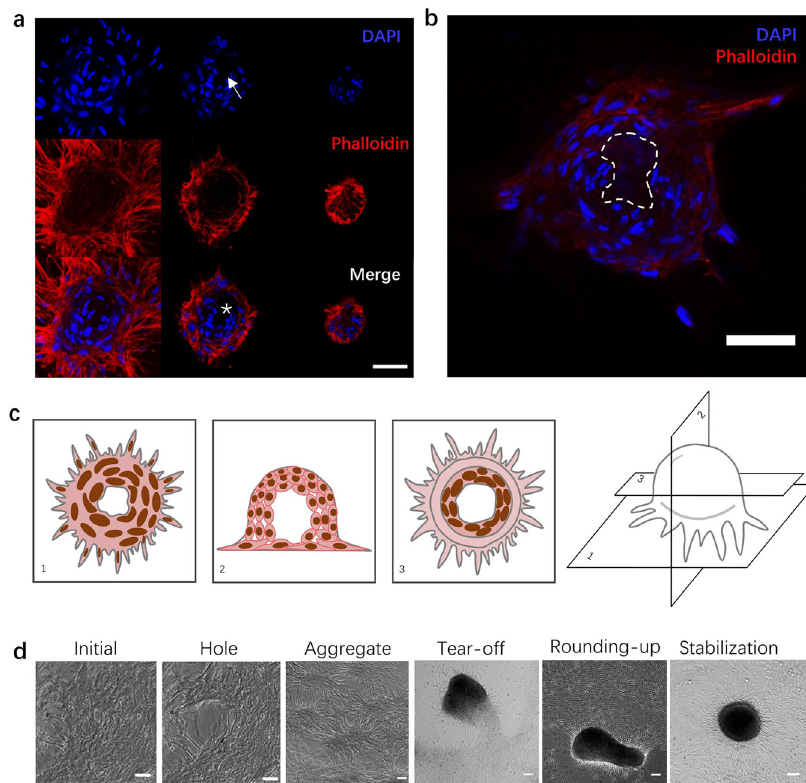
Fig. 1 Cellular organization in SMC clusters and sequence of steps leading to cluster formation. a Confocal images of cellular organization within a cluster. From left to right: z-stack from bottom to top of a cluster for the nucleus (DAPI channel; top row), F-actin (phalloidin channel; middle row), and both channels combined (bottom row). Note the lower cell density zone in the center of the cluster (white arrow on DAPI image; white * on merge image). Scale bar: 50 μ m. b A confocal optical section through the midplane of a cluster to more clearly illustrate the lower cell density zone in the center (dashed contour). Scale bar: 50 μ m. c Schematic of cellular organization within SMC clusters. d Phase contrast images of the sequence of fi ve distinct events leading to cluster formation. From left to right: initial condition, crack development, aggregate formation, aggregate tear-off, cluster rounding-up from oblong to circular cross-section, and cluster stabilization. Scale bars: 100 μ